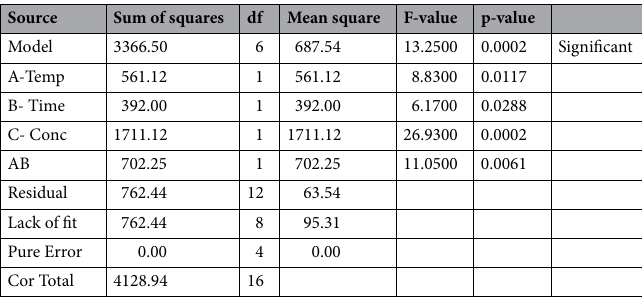
Table 4. Analysis of variance (ANOVA) of the new model.